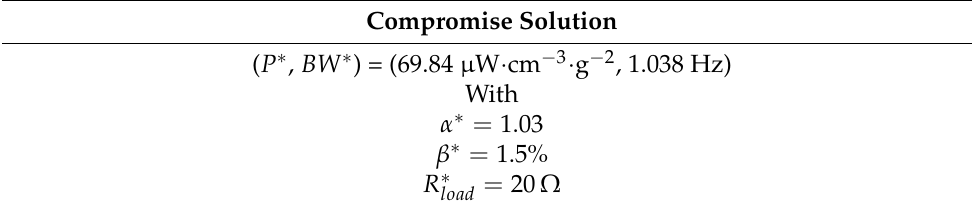
Table 3. Results of the multiobjective optimization of the 2-DOFs